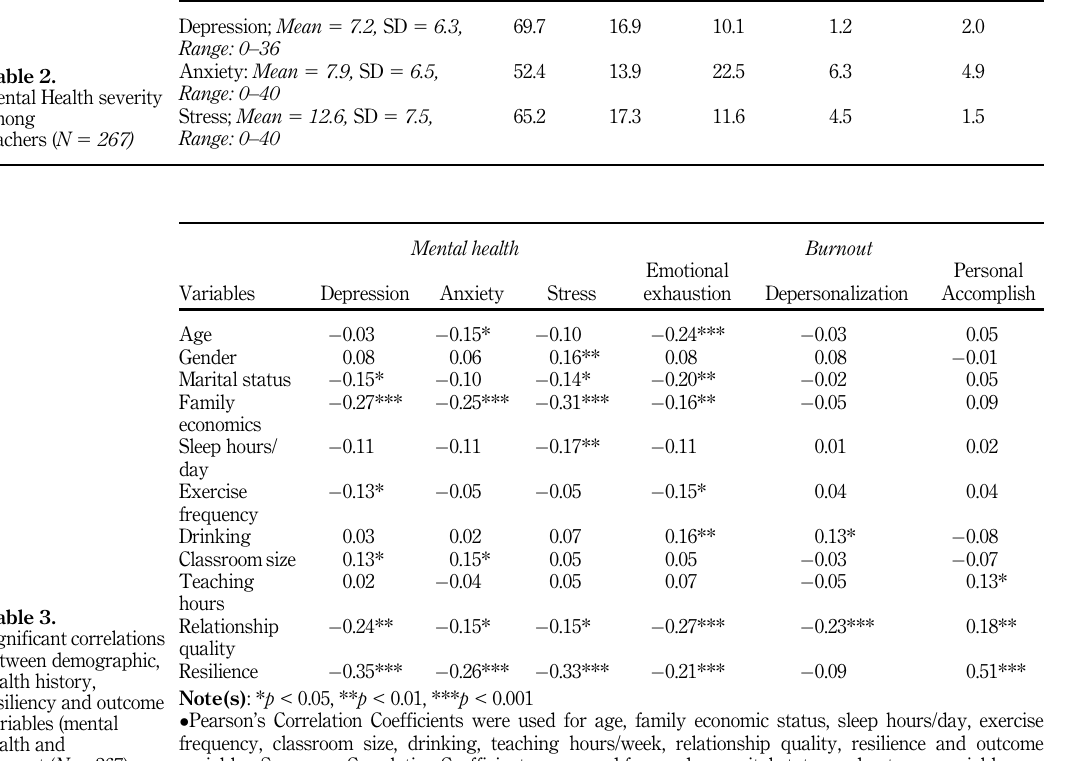
between demographic, health history, resiliency and outcome variables (mental health and burnout ( N 5